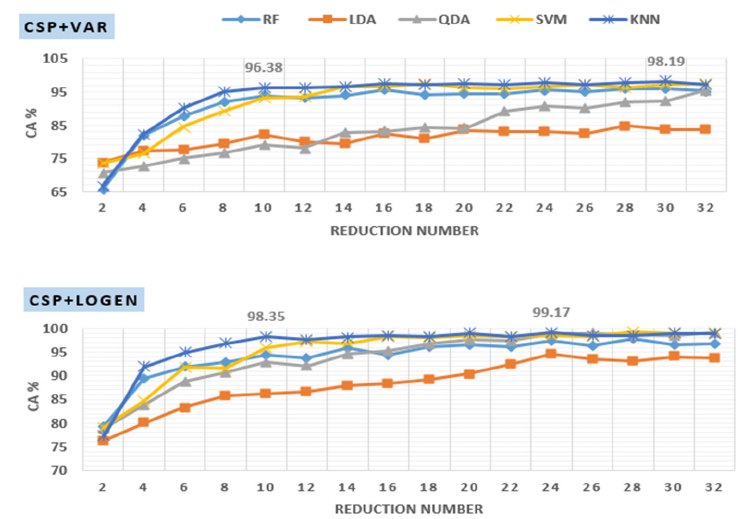
Figure 8. Effect of reduction number on KNN classification accuracy applied to features extracted using CSP+Var ( top ) and CSP+LogEn ( bottom ). using CSP+Var ( top ) and CSP+LogEn ( bottom